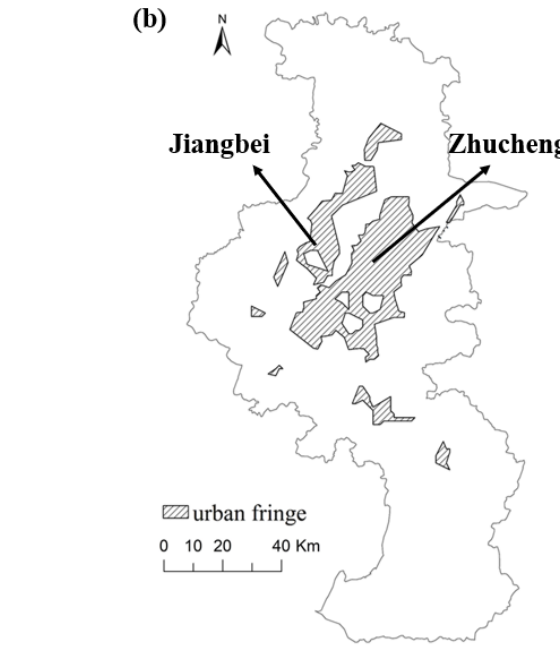
Figure 10. Detection of urban fringe in Nanjing: ( a ) clustering result; ( b ) spatial boundaries of urban fringes. Table 1. Statistical information of the clustering results by our method.